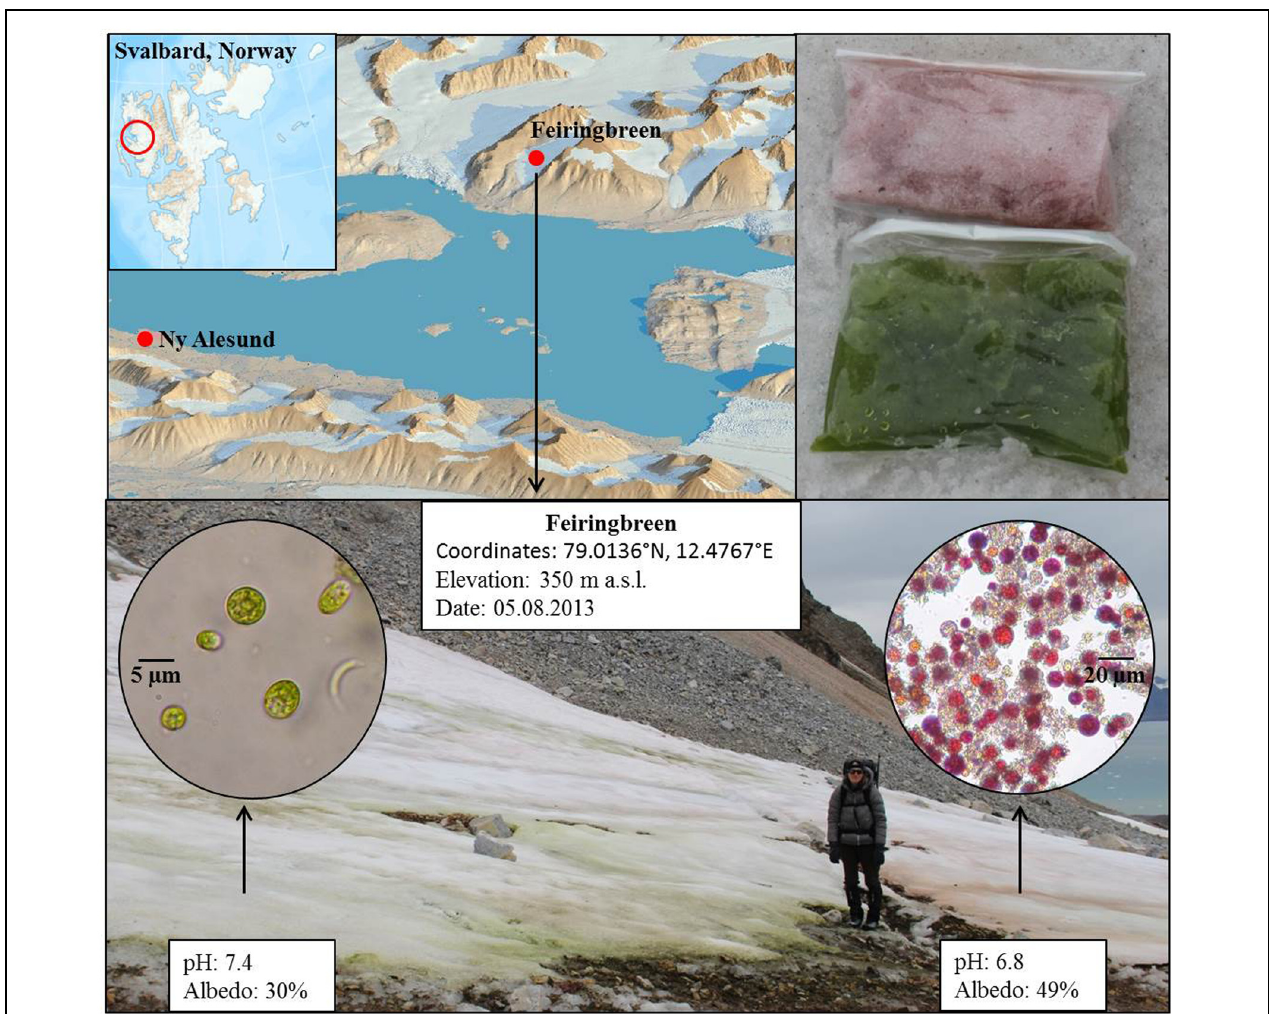
FIGURE 1 | Map (top; left) showing the sample location on Feiringbreen in Svalbard, bags with sampled green and red snow (top; right) and image of the site with superimposed microscopic images of the snow algal cells (bottom). Shown are also coordinates and in field measured pH and albedo values for each snow type.